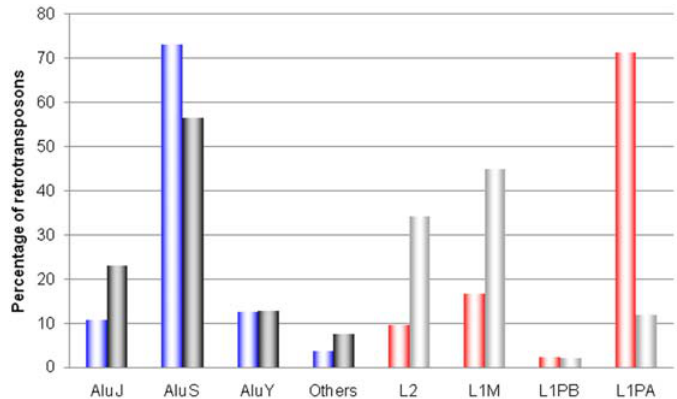
Figure 3. Alu and L1 subfamilies involved in RRMI events. The proportion of Alu elements involved in Alu -RMI events (blue bars) and the proportion of Alu elements in each subfamily (black bars) are compared in the left side. The proportion of LINEs involved in L1-RMI events (red bars) and the proportion of L1 elements in each subfamily (gray bars) are compared in the right side.